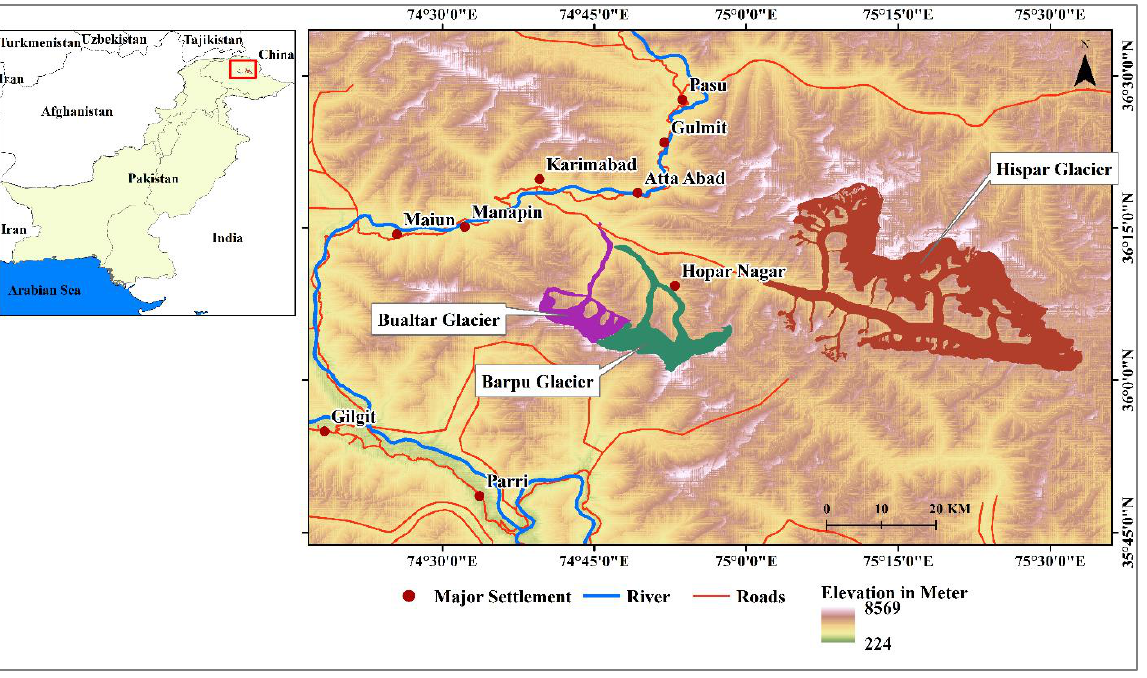
Figure 1: Location map of the study area